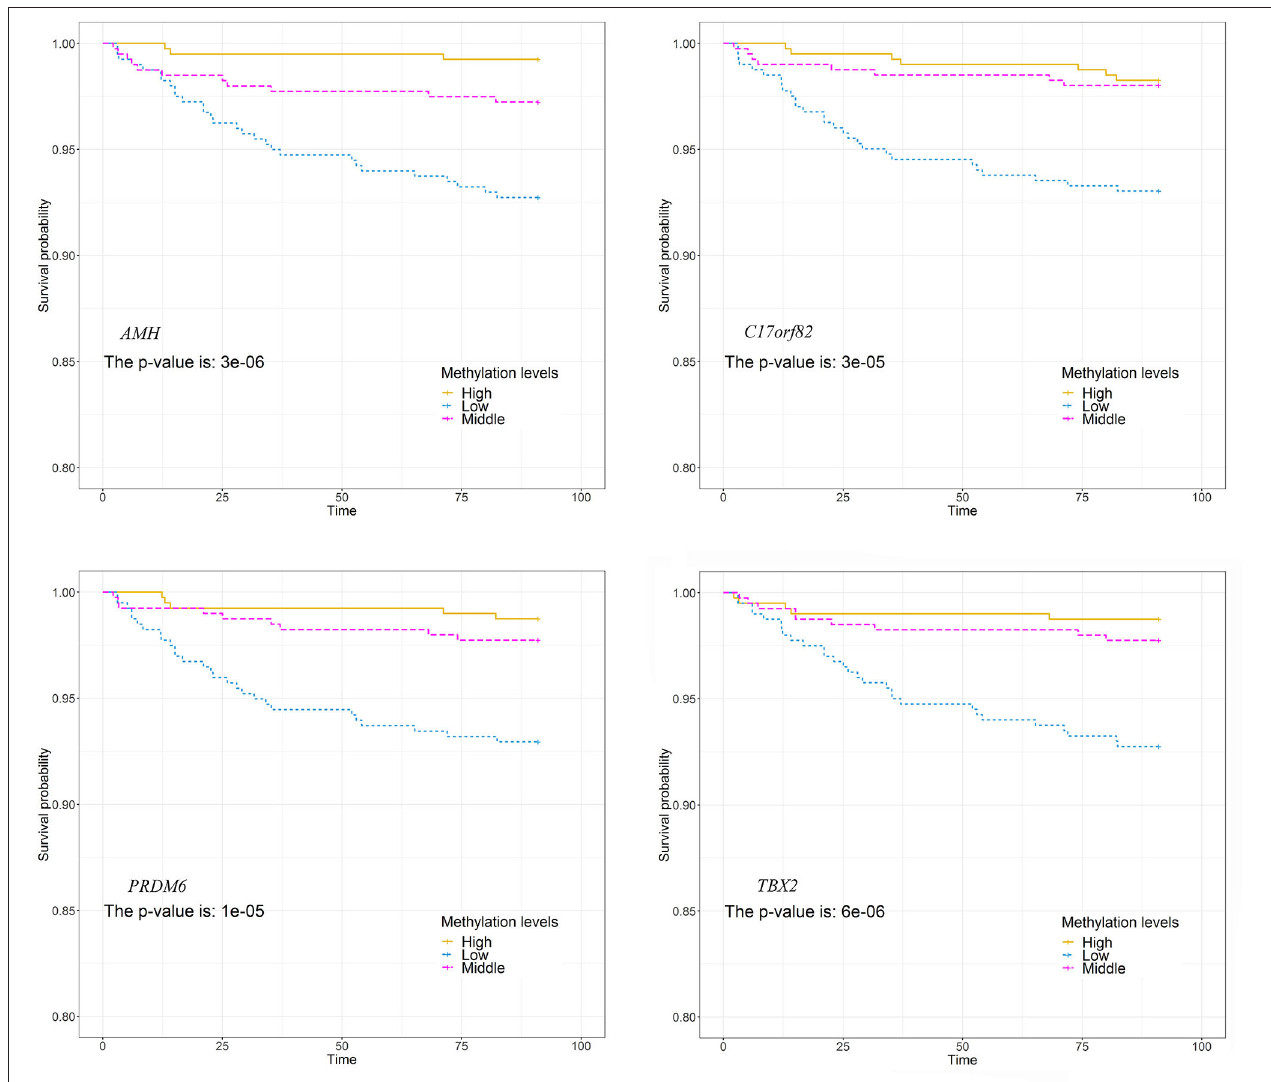
FIGURE 5 | Association between DNA methylations and survival. The patients were separated into three groups by tertiles of methylation levels of each of the four targets. The survival rates between the three groups were compared. Patients who have higher methylation levels of these genes have higher survival rates than patients with lower methylation